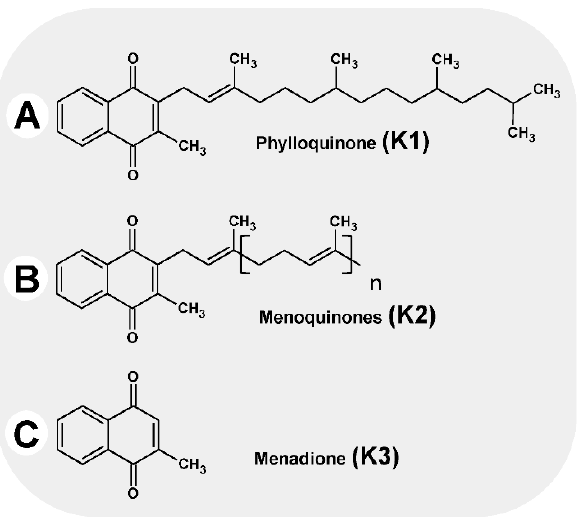
Figure 1. Vitamins K.